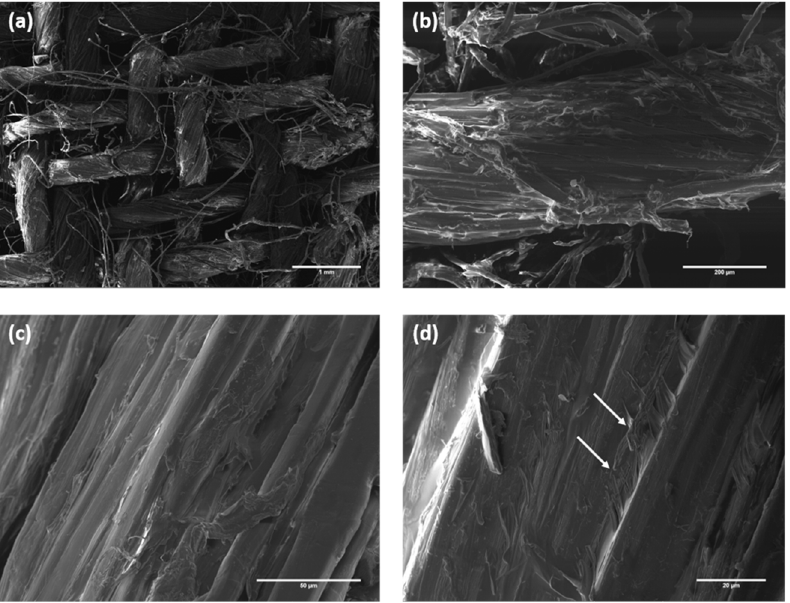
Figure 13. SEM micrographs showing the flax fabrics modified with 0.4 M SA at different